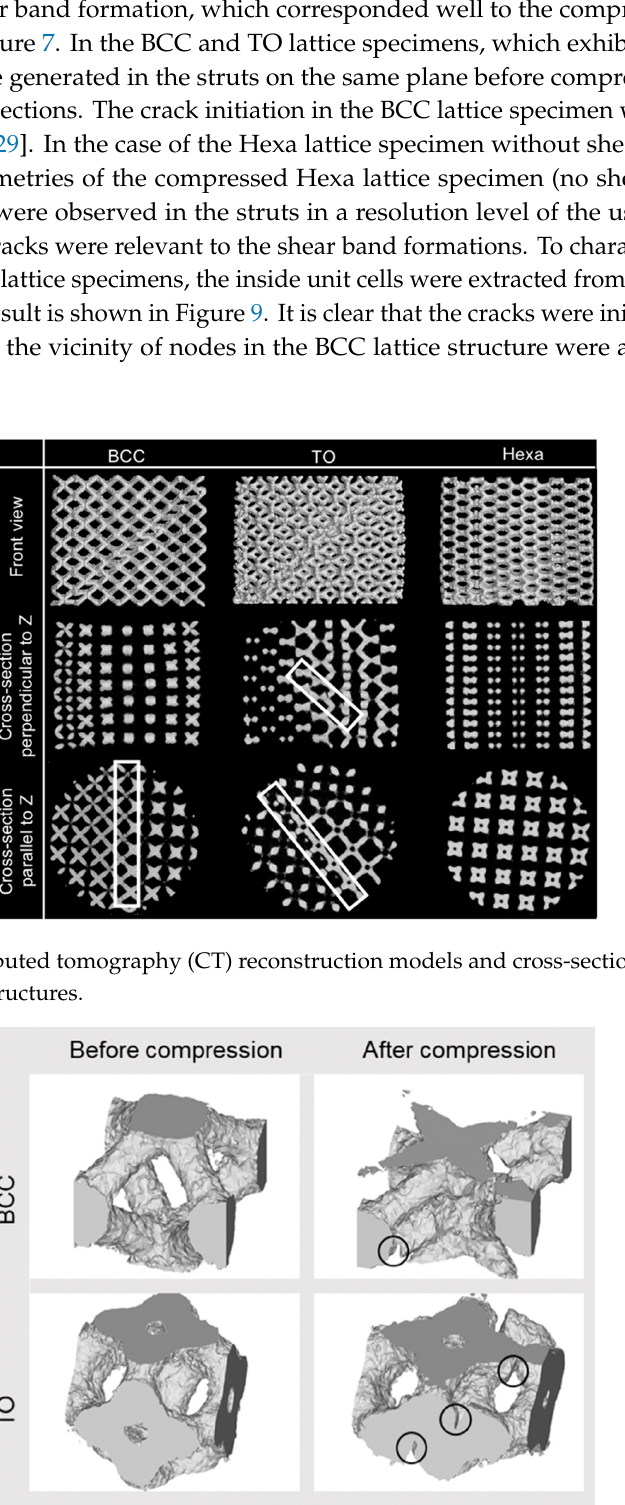
Figure 9. X-ray CT images of unit cells of BCC and TO lattice specimens, before and after compression.